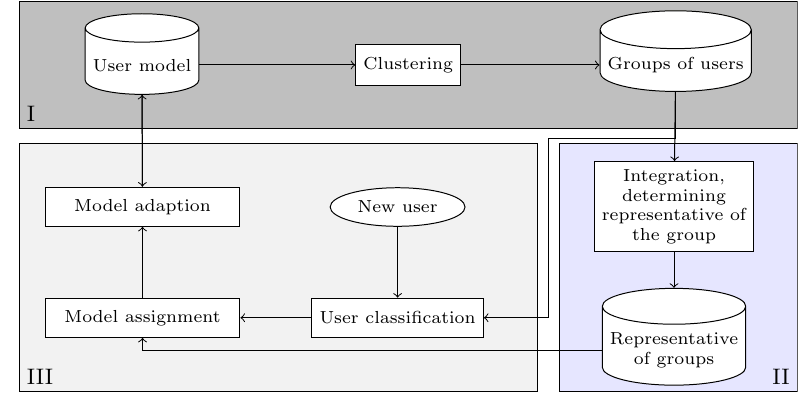
Fig. 2. Conceptual schema of the proposed